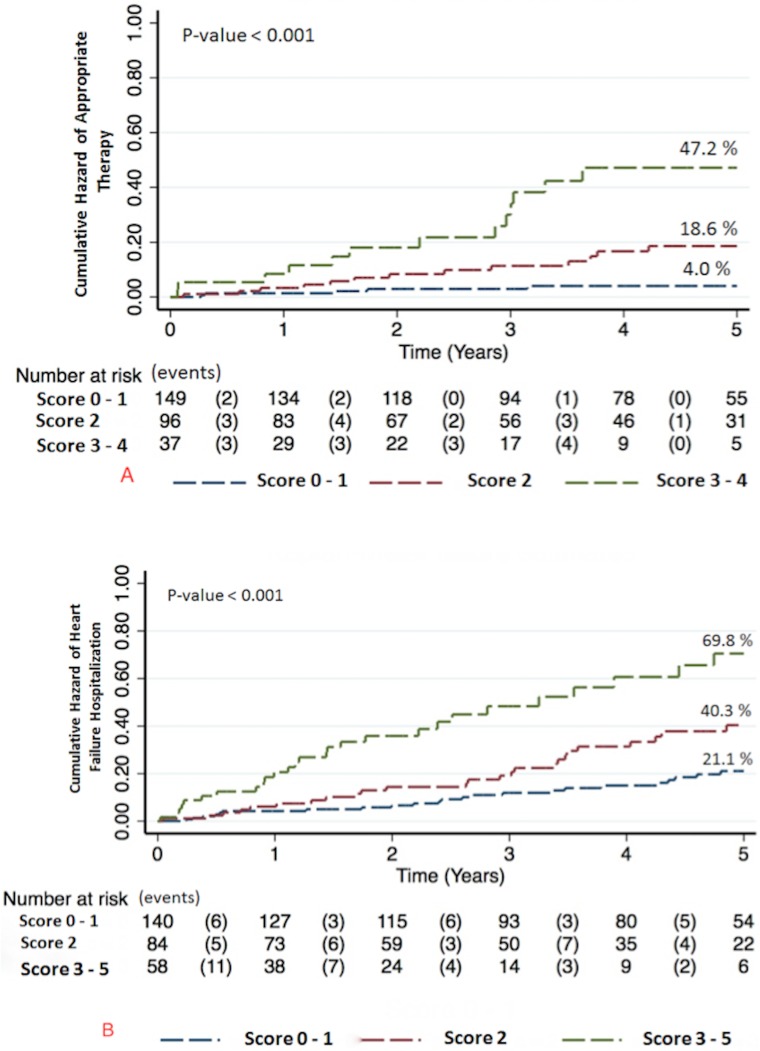
Cumulative hazard according to score categories.(A) Cumulative hazard of appropriate therapy according to score categories. (B) Cumulative hazard of HF hospitalization according to score categories.